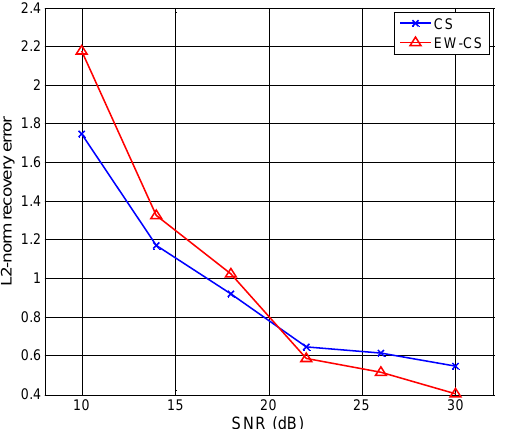
Figure 16. The l -norm recovery error with different SNR. 2